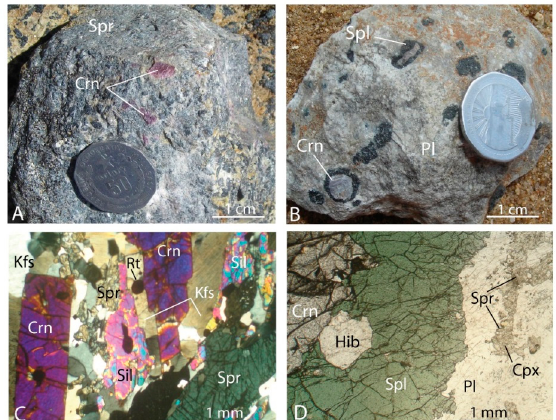
Figure 47. The Ambatomena ruby deposit, south of Betroka, Southern Madagascar. ( A ) Ruby (Crn)-bearing sapphirinite (Spr); ( B ) plagioclasite (Pl) with whitish corundum (Crn) showing a corona of spinel (Spl); ( C ) microscopic image of ruby-bearing sapphirinite with a granoblastic texture of K-feldspar (Kfs), sapphirine (Spr), sillimanite (Sil), and rutile (Rt). The ruby sometimes has a corona of sapphirine and K-feldspar; ( D ) microscopic image of the corundum-bearing plagioclasite. The texture is granoblastic decussate with plagioclase (Pl) and corundum. The plagioclase is associated with some